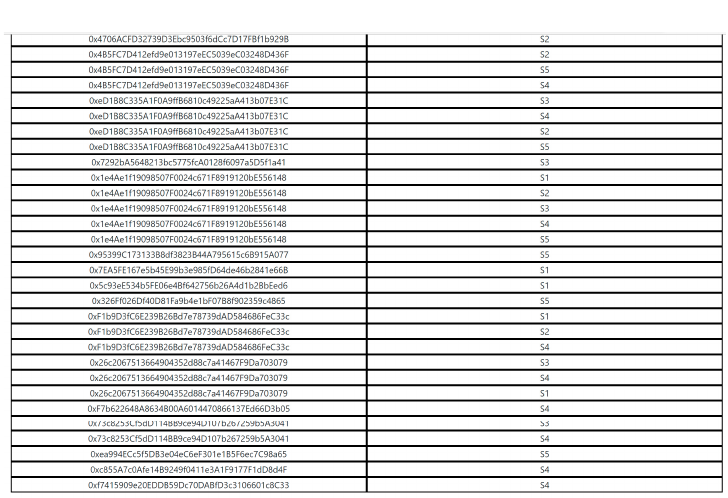
Figure 17. Banned List for Malicious SRs.